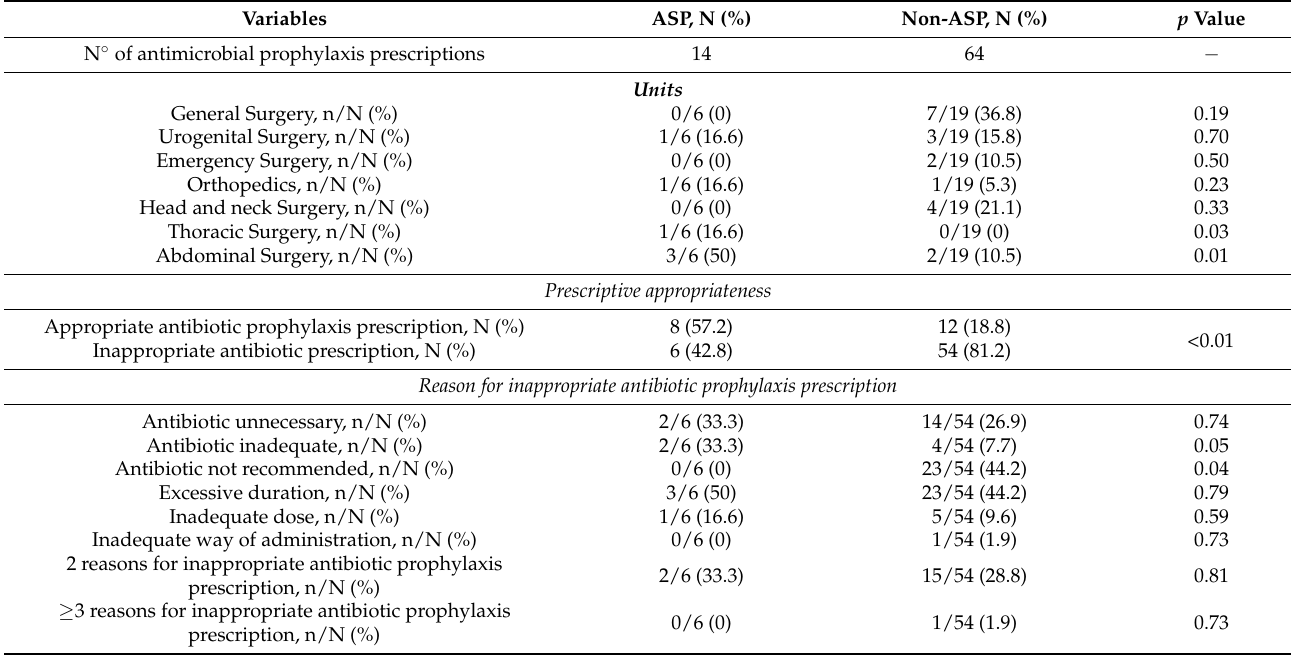
Table 5. Adequacy of antibiotic prophylaxis between ASP and non-ASP